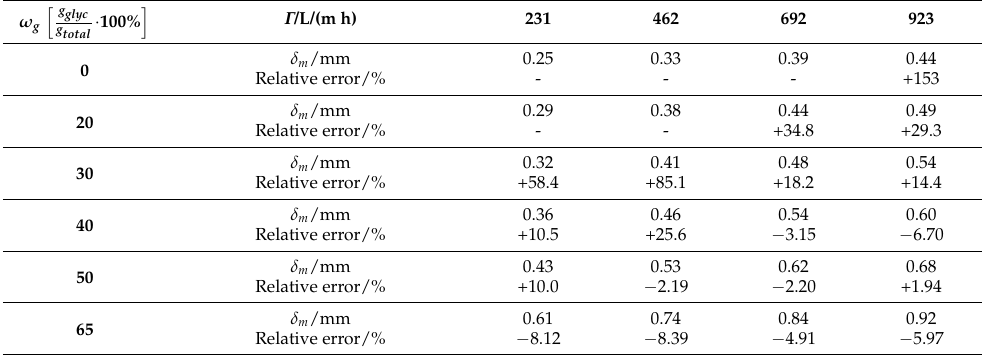
Table 3. Relative errors of the glycerol mass concentration measurement shown in Figure 14 in com- parison to the set glycerol mass concentration.